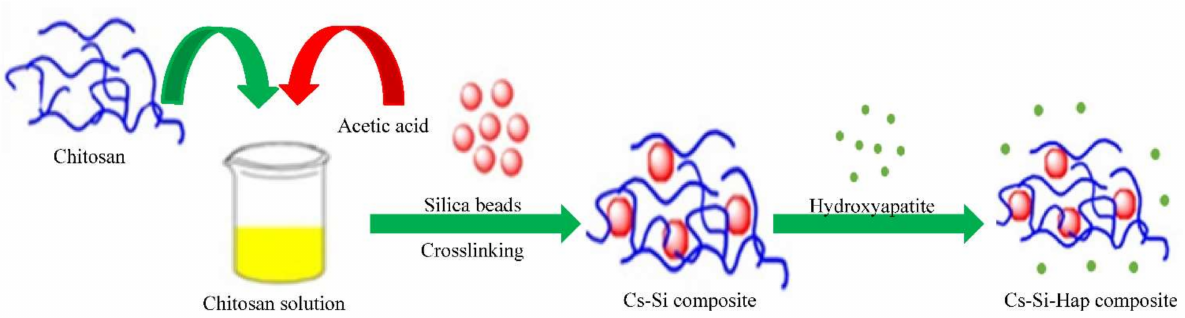
Figure 1. Schematic representation of Cs–Si–Hap composite